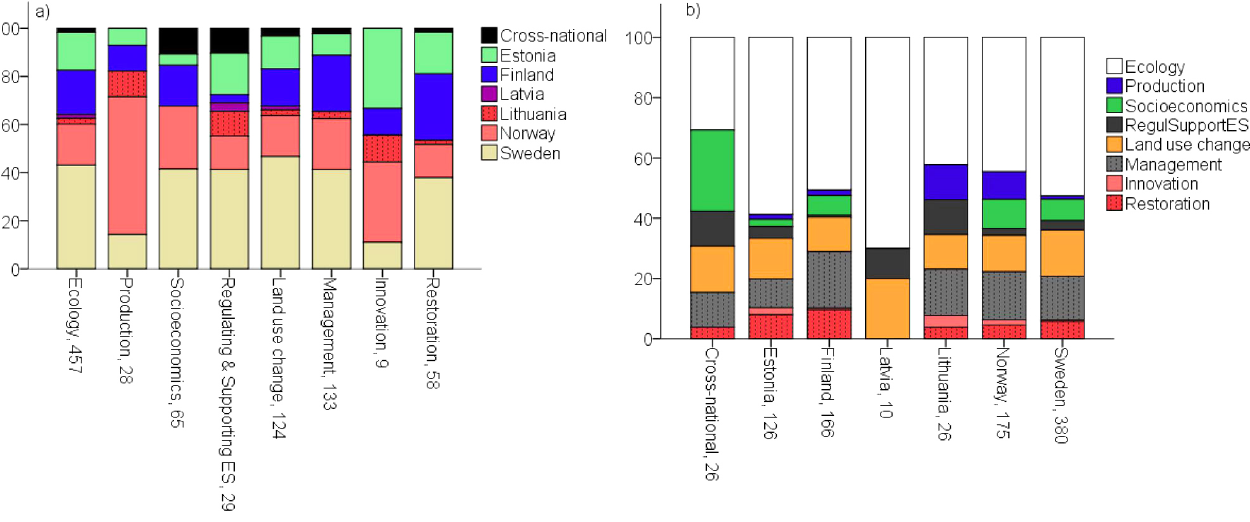
Fig. 6 . The relative representation (%) of the research aspects of semi-natural habitats (a) within each country and (b) among the countries in the boreal region. Cross-national stands for the region overall, including Europe-wide studies. The number after a country name denotes the number of